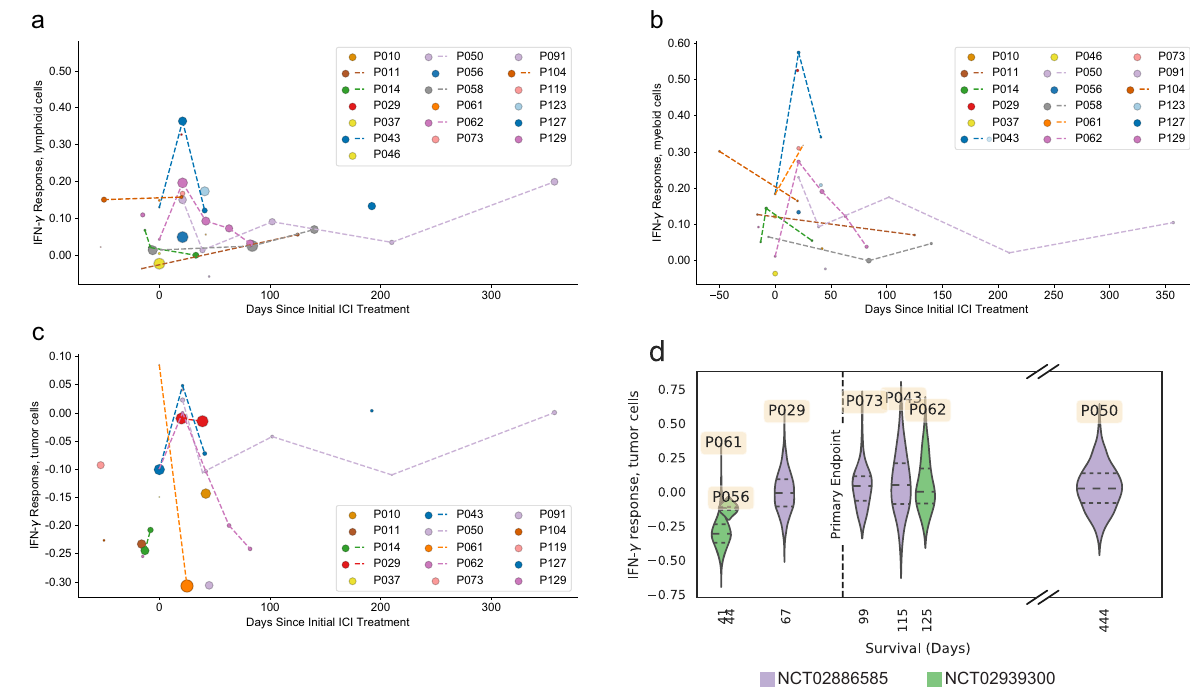
Fig. 3 Acute immune response in CSF subsequent to intravenous ICI and relationship to survival. a – c Mean module score for IFN- γ response within samples over time points for lymphoid ( a ), myeloid ( b ), tumor cells ( c ). Samples from a single patient are connected with a dashed line. The size of markers is proportional to the number of relevant cells in a sample; only samples with more than 5 cells of the corresponding type are considered. Points at 0 days relative to ICI administration are pre-treatment. d Violin plots of IFN- γ response for tumor cells plotted against survival (time-on-trial), for samples taken <30 days after initial ICI administration. Medians and upper and lower quartiles are indicated in each violin plot by dashed